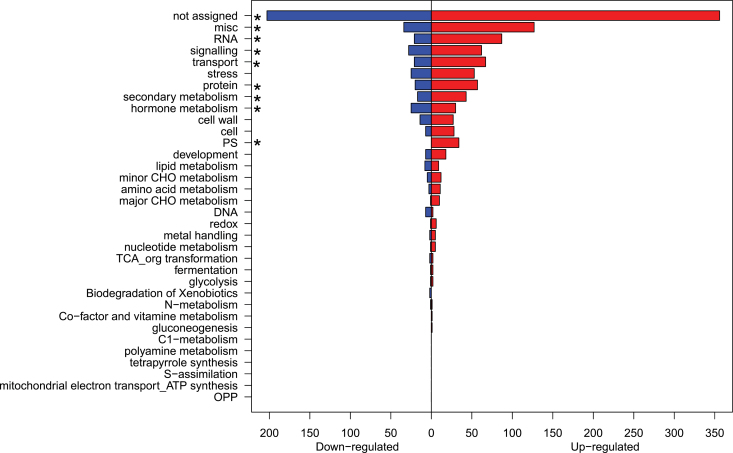
Distribution of the Mapman functional categories of genes significantly down- or up-regulated in berries cultured in vitro in high glucose (468mM) compared with low glucose (58mM) in the culture medium. A total of 1515 significantly differentially expressed genes were identified by an adjusted P<0.05 after false discovery rate correction. Three biological replicates were used. Asterisks indicate that the functional categories of the MapMan ontology are significantly enriched in the significantly differentially expressed genes at P<0.05 after Bonferroni correction. (This figure is available in colour at JXB online.)